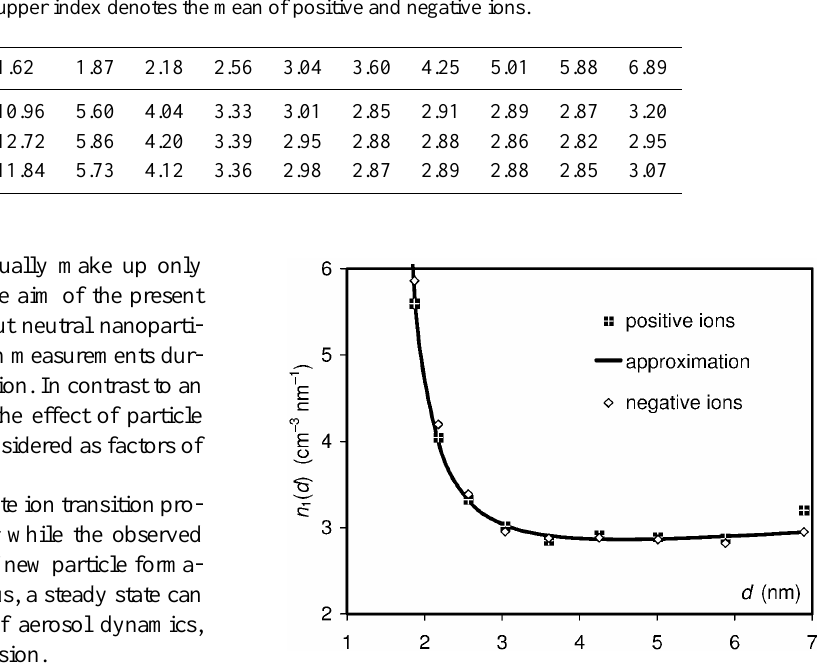
Fig. 1. Near-median size distribution of intermediate ions n 1 ( d ) according to Table 1 and the approximation Eq. (4).